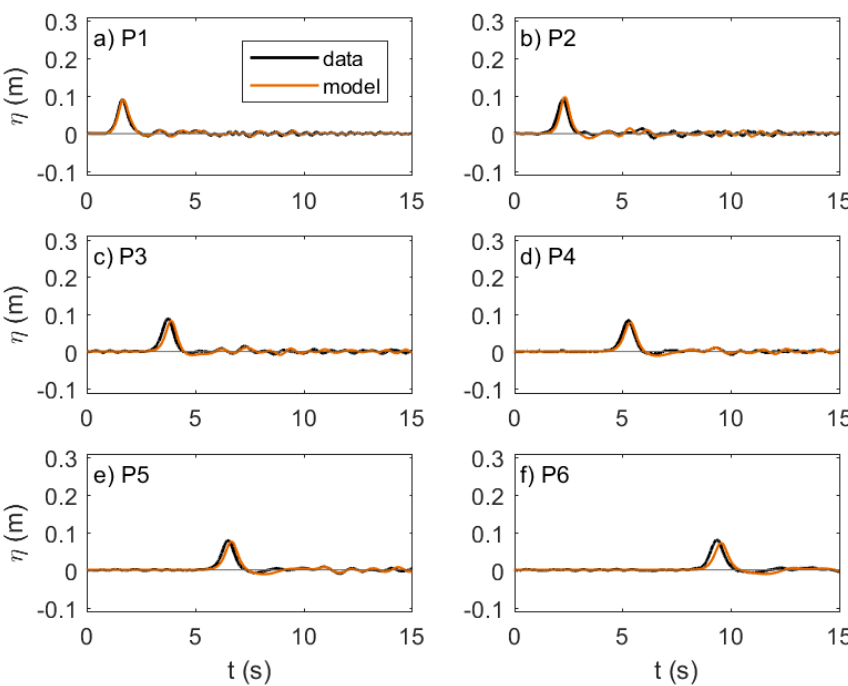
Figure 5. Water surface elevation time series for the low landside mobility case from experimental observations and numerical simulation. Time t = 0 s is referenced to the slide impact time. Wave probe sites shown in Figure 1 are: ( a ) P1; ( b ) P2; ( c ) P3; ( d ) P4; ( e ) P5; and ( f ) P6.